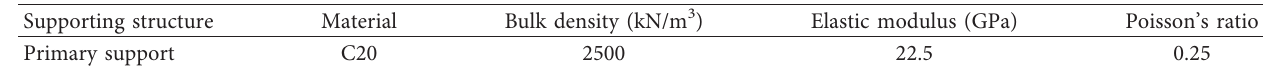
Table 2: Physical and mechanical parameters of lining